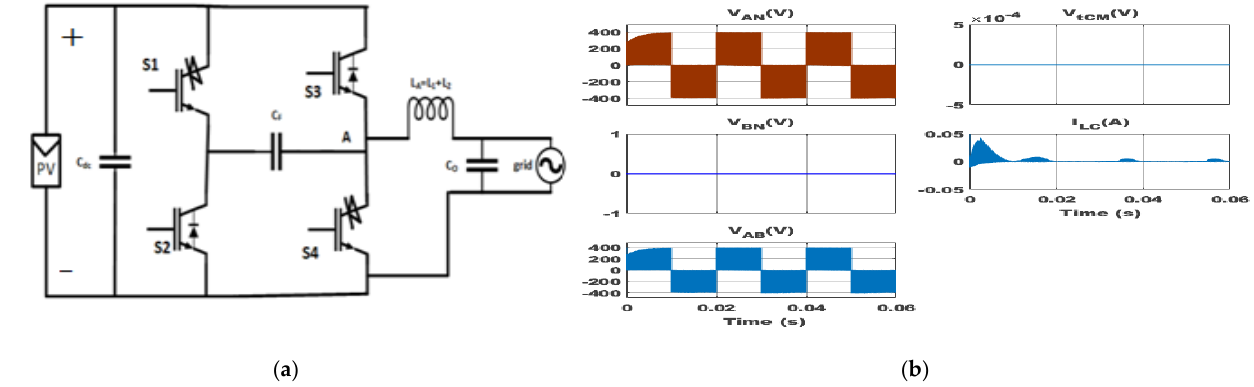
Figure 22. Siwakoti-H topology: ( a ) circuit structure; ( b ) simulation results.